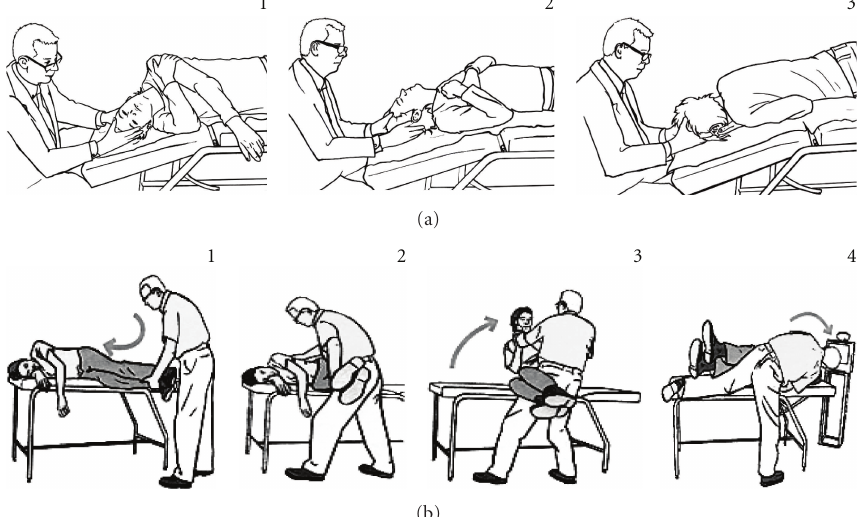
Figure 2: Epley (a) and Semont-Toupet (b) maneuvers for a right posterior canal BPPV. Numbers indicate the action